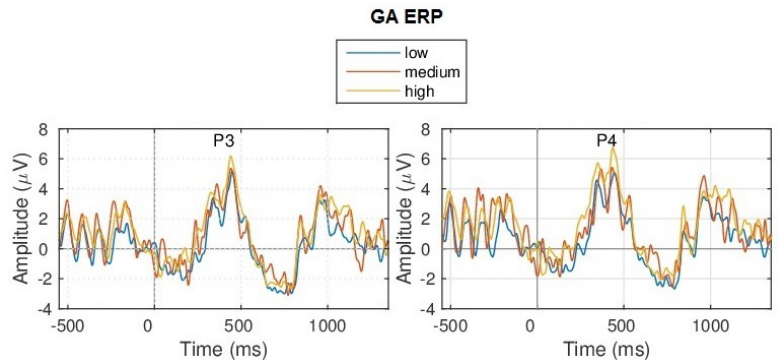
Figure 11. GA ERP for Frac on 3 complexity levels according to CFD, for P3 and P4 channels.